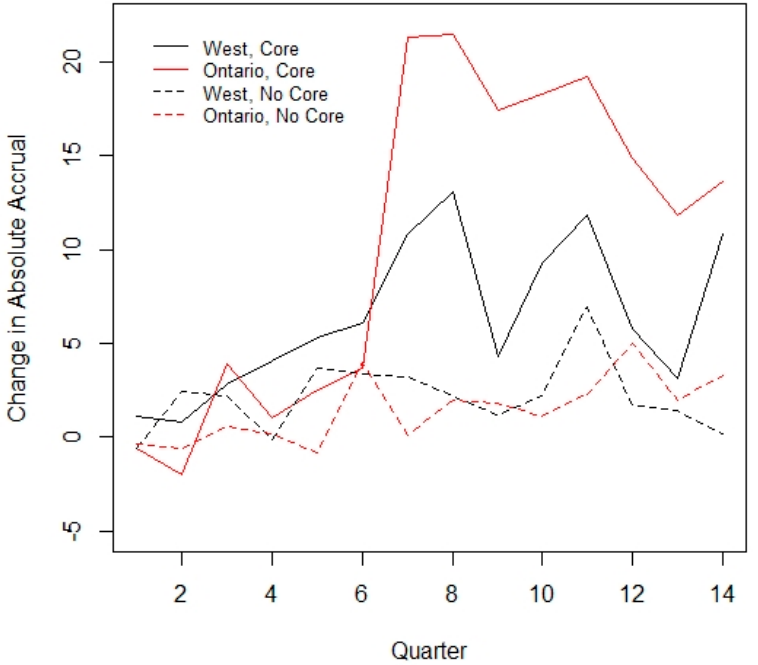
Figure 3. Interaction between core funding and time .